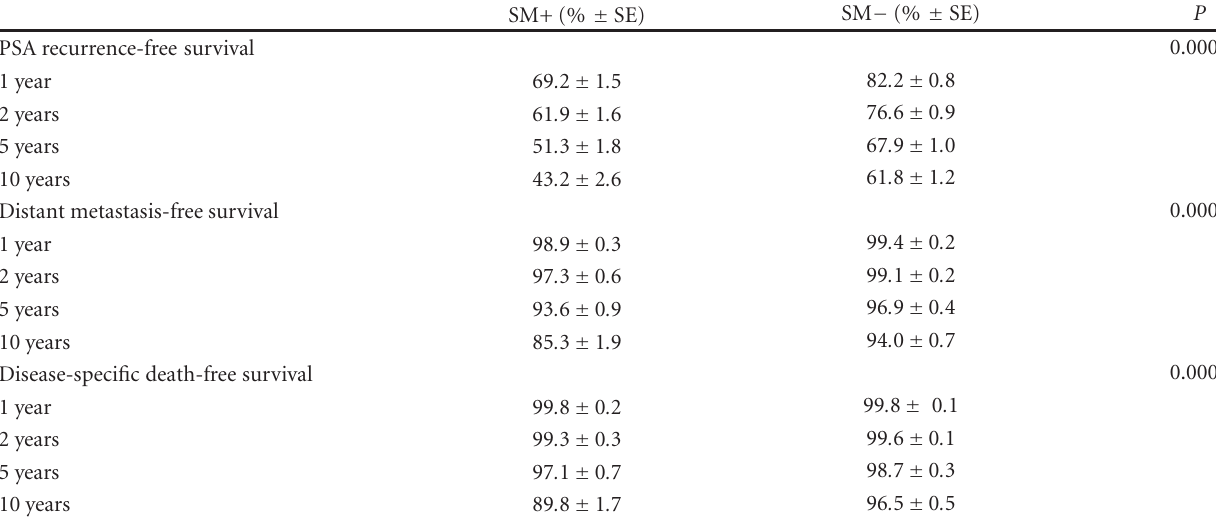
Table 2: Outcomes after radical prostatectomy and impact of positive and negative surgical margins